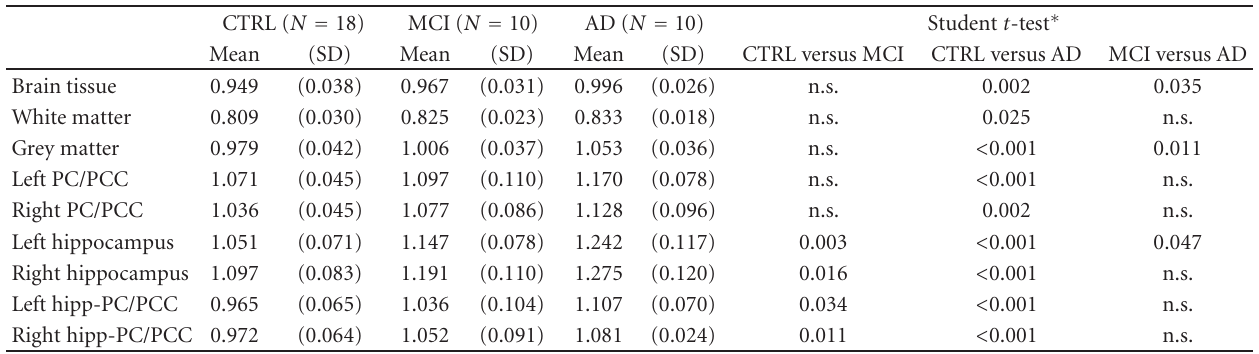
Table 3: Mean Di ff usivity ( × 10 − 3 mm 2 s − 1 ) in CTRL, MCI, and AD patients.